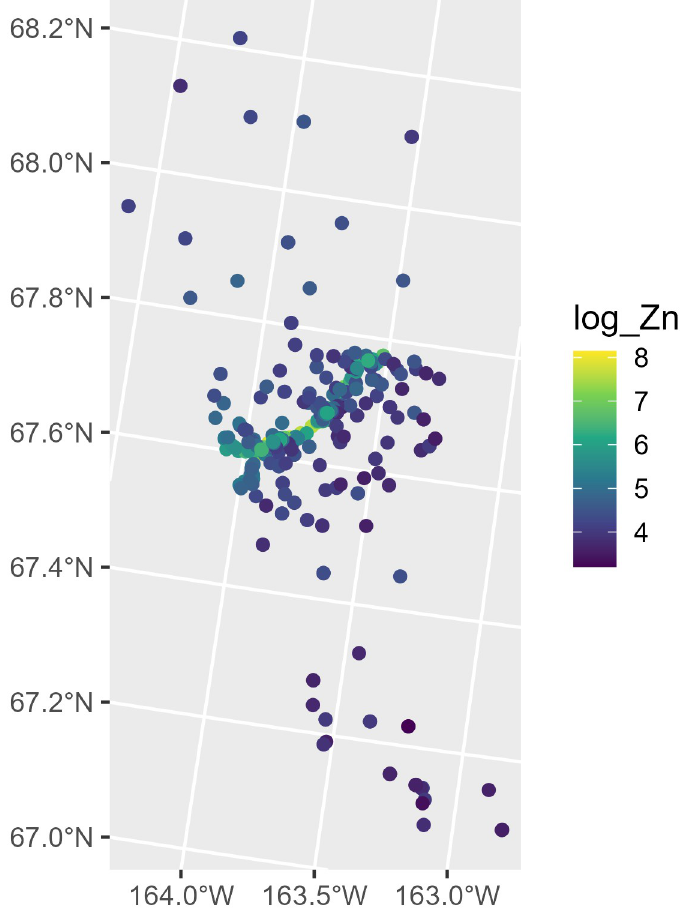
Fig 1. Distribution of log zinc concentration in the moss